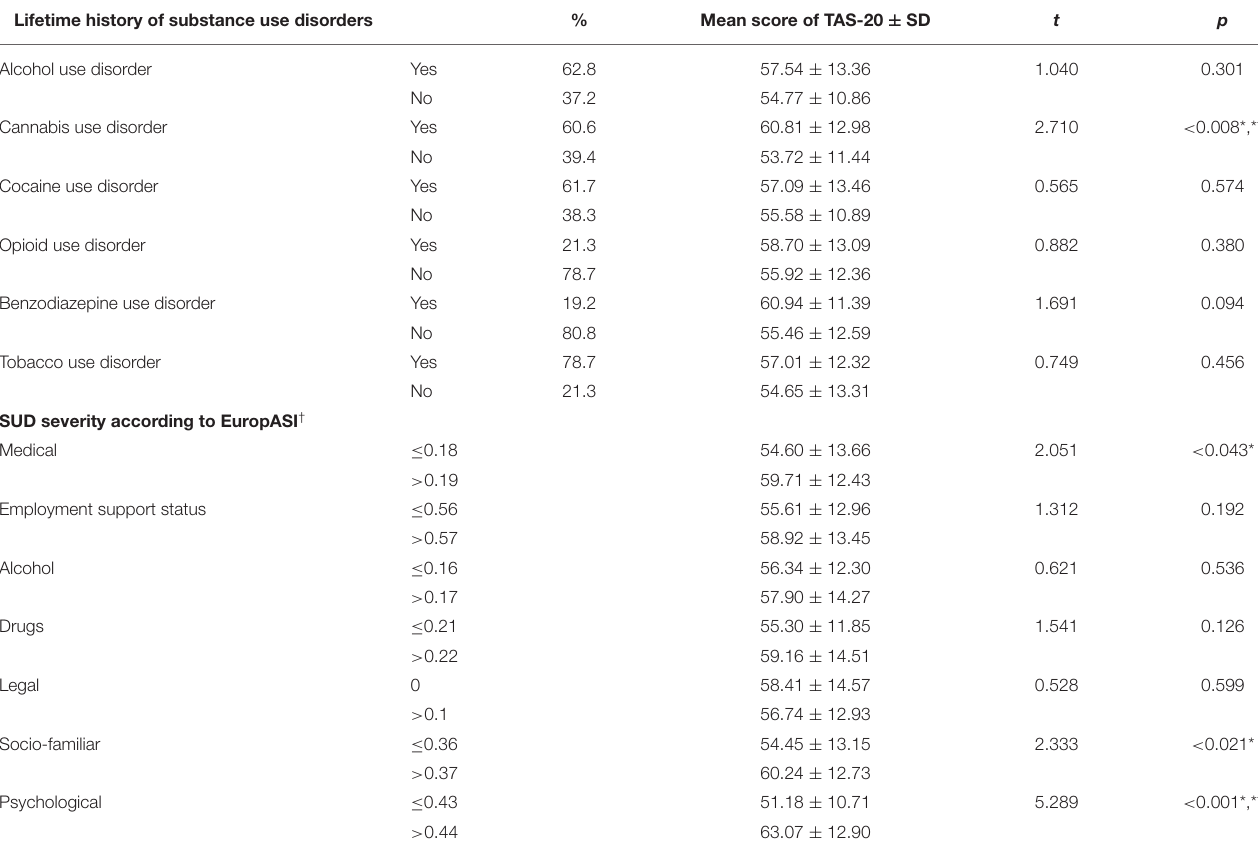
TABLE 2 | Substance use related variables analyzed by comparing to mean scores of